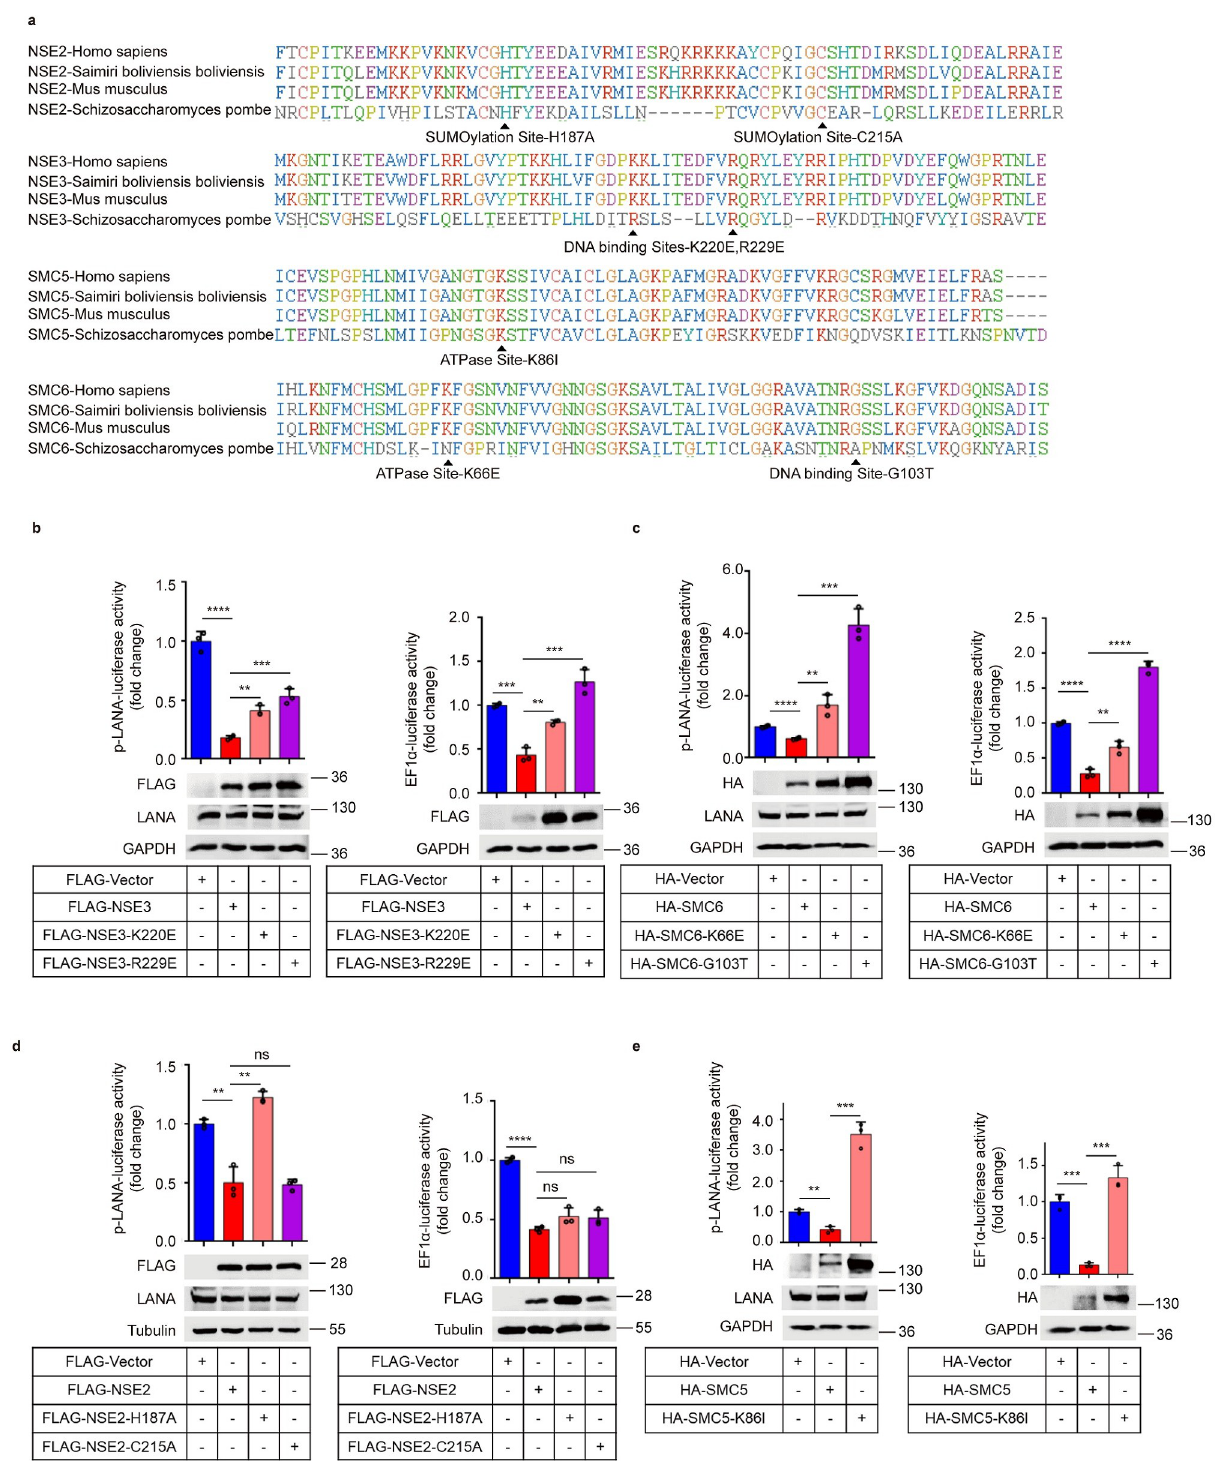
Fig 4. The SMC5/6 complex suppresses gene transcription in ATPase- and DNA-binding activity-dependent manners. (a) Schematic diagram of DNA-binding, SUMOylation and ATPase mutations of the SMC5/6 complex. Mutate the corresponding active sites of homo sapiens according to the site mutations of yeast. (b) Effect of DNA binding-defective mutates of NSE3 on KSHV gene transcription. HEK293T cells were transfected with 200ng LANA-promoter (left) or EF1 α promotor (right), inactive mutations and other plasmid DNA as indicated. 36h post-transfection, cells were lysed and luciferase activities were analyzed. In addition, lysates of cells were subjected to western blot analysis. (c) Effect of inactive DNA-binding mutation and